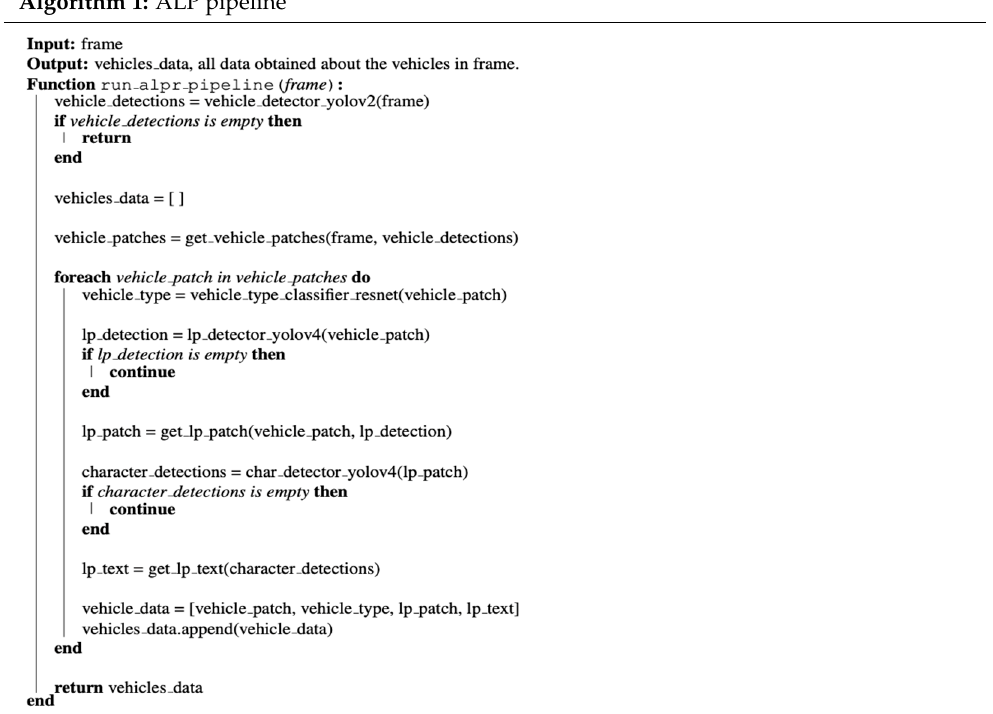
Table 2. Vehicle detection model